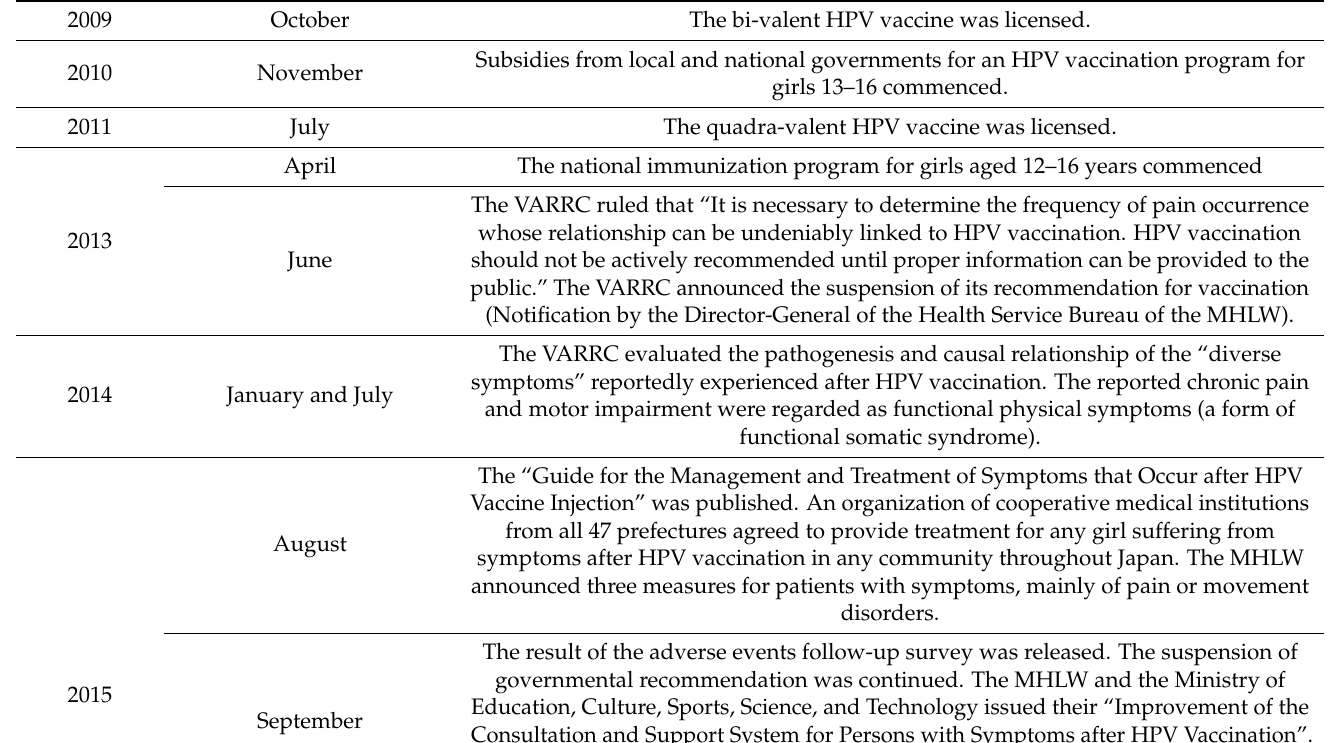
Table 1. Timeline of the policies and events related to HPV vaccines in